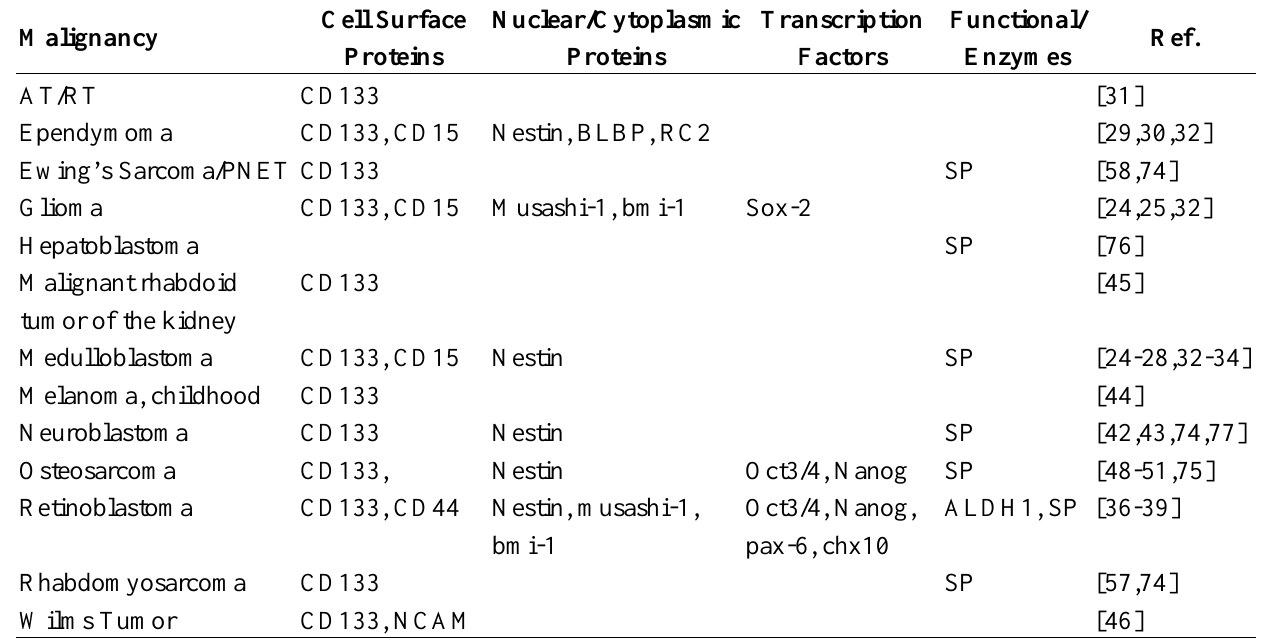
Table 1. Markers used to define tumor stem cells (TSC) in pediatric cancers.